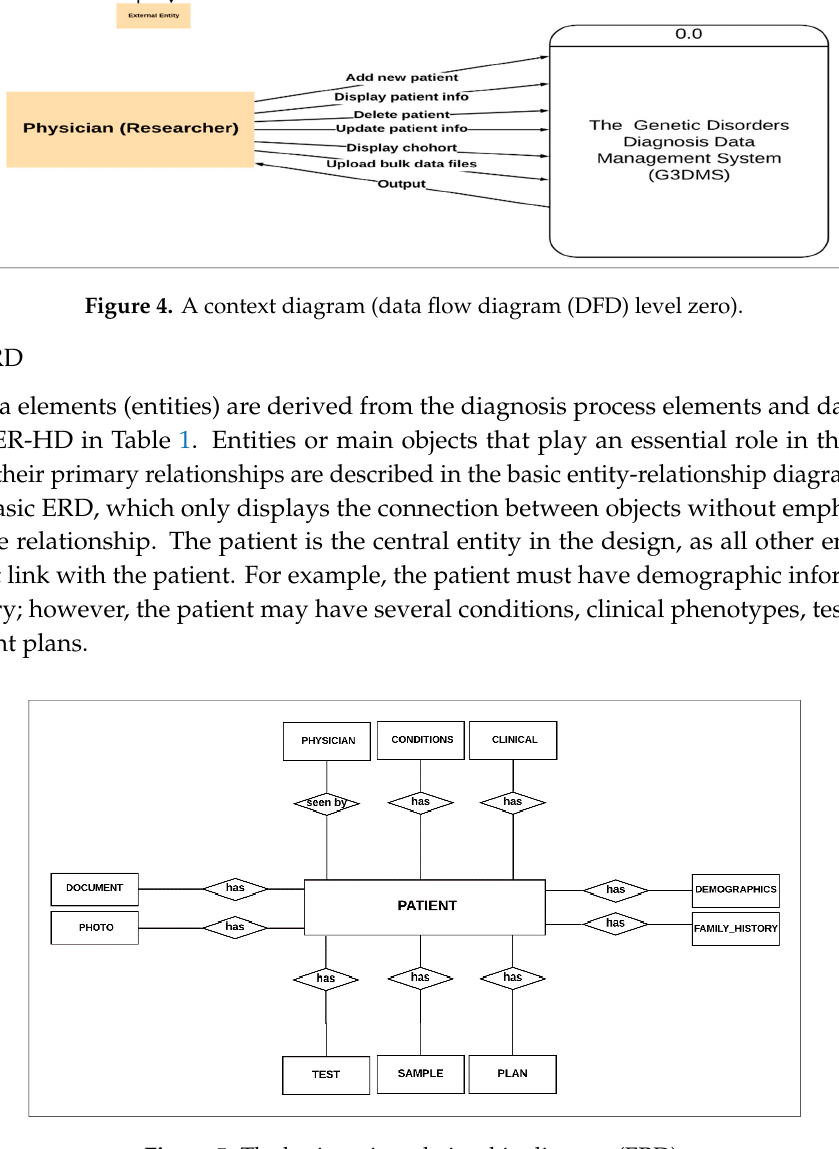
Figure 5. The basic entity-relationship diagram (ERD).